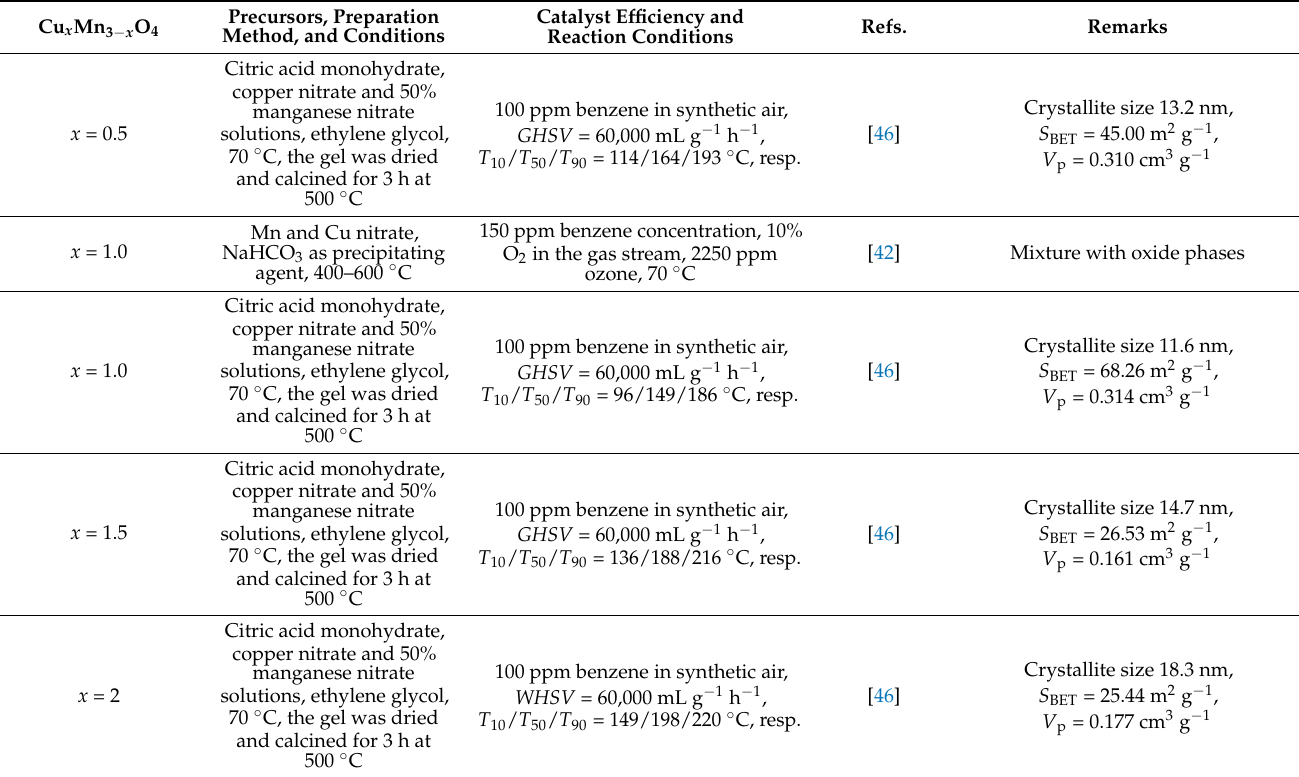
Table 8. Removal of benzene from the air in the presence of Cu x Mn 3 − x O 4 catalysts. Cu x Mn 3 − x O